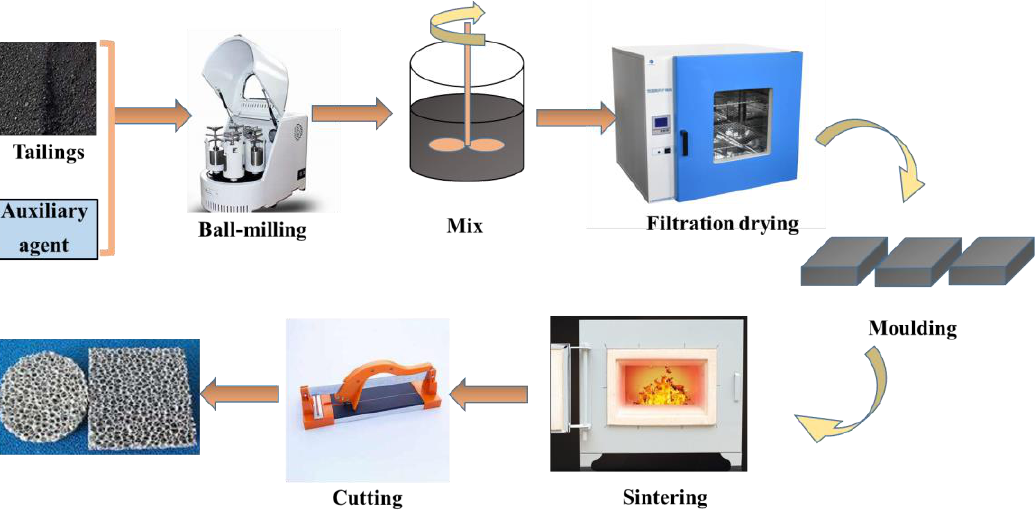
Figure 3. Preparation process of the foam ceramics.